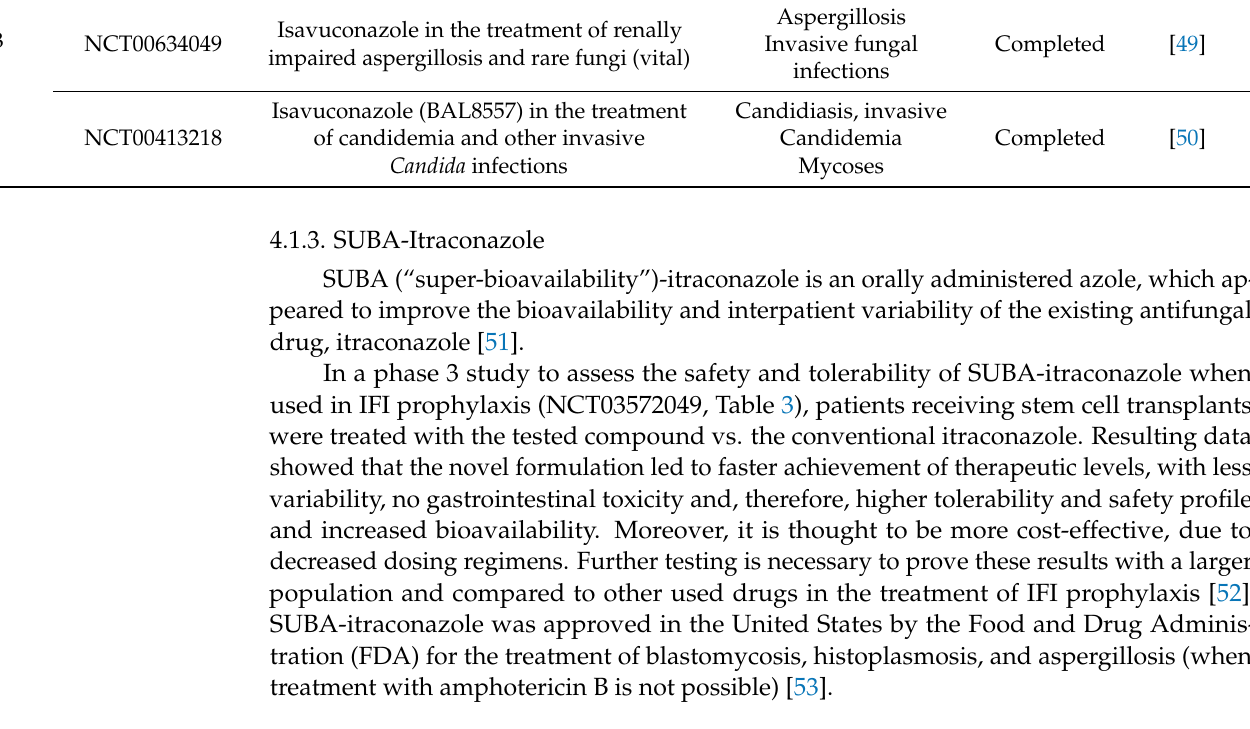
Table 3. Clinical trial for SUBA-itraconazole